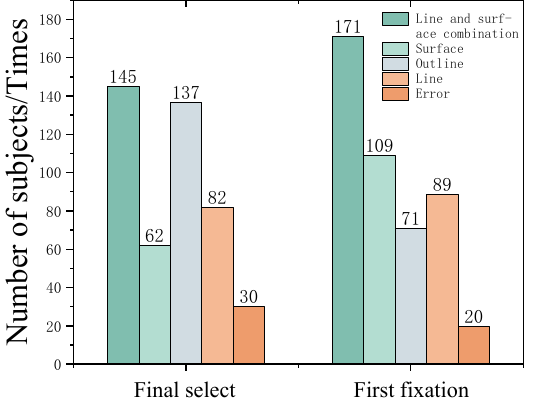
Figure 5. Comparison of the selection and fixation levels of different symbol types.